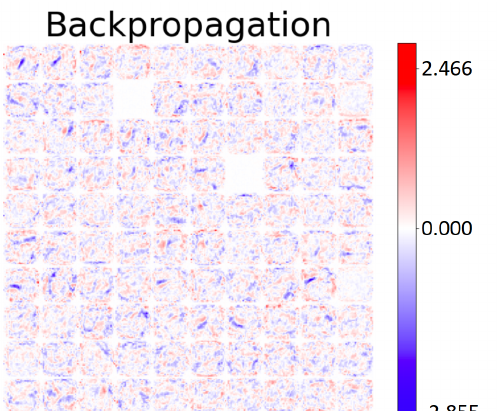
Figure 1. A hundred randomly selected feature detectors for MNIST classification out of 2000 are shown. On the top are the shown weights learned by the biologically plausible model’s unsupervised learning component; on the bottom are the weights learned by the classic neural network model by using end-to-end backpropagation.